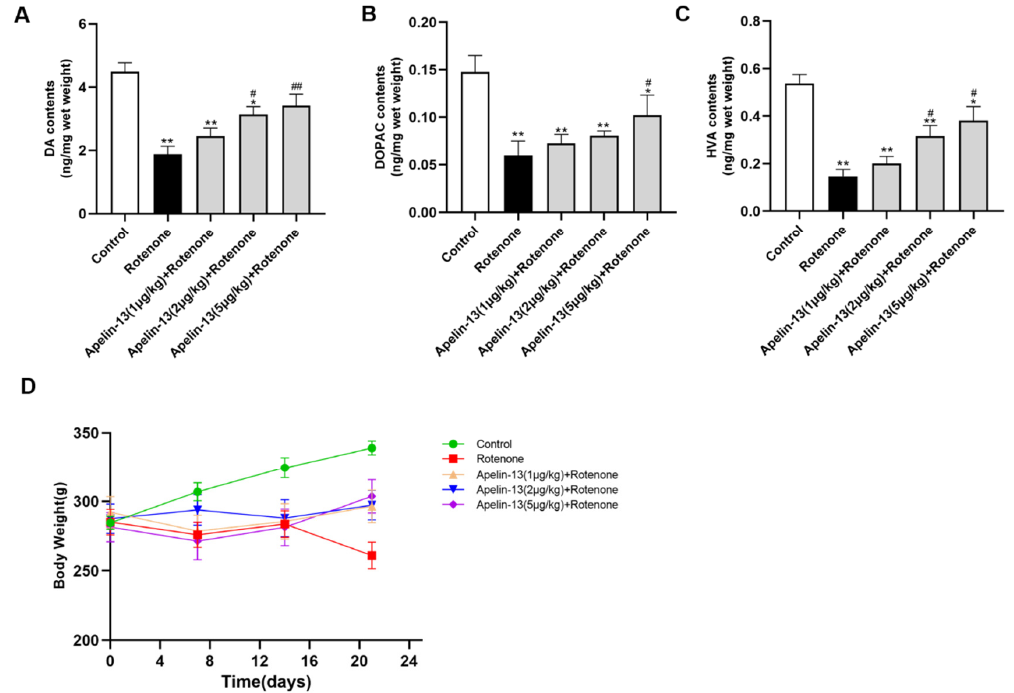
Figure 14. Effects of apelin-13 on the content of DA and its metabolites in the Str of rats with rotenone administration. ( A – C ) The levels of DA, DOPAC, and HVA were analyzed by HPLC analysis in the str. There was a reduction of DA, DOPAC, and HVA levels in the rotenone group. DA, DOPAC, and HVA levels were restored in the Apelin-13 (5 µ g / kg) + rotenone and Apelin-13 (2 µ g / kg) + rotenone groups; DA and HVA levels were restored in the Apelin-13 (2 µ g / kg) + rotenone group. ( D ) The body weight of the rats was recorded, and is shown. Rotenone induced a loss of body weight, which was fully abolished in the Apelin-13 (1 µ g / kg, 2 µ g / kg, and 5 µ g / kg) + rotenone groups. Data are presented as mean ± SEM of twelve replications. * p < 0.05; ** p < 0.01 compared with the control; # p < 0.05; ## p < 0.01 compared with the rotenone group.